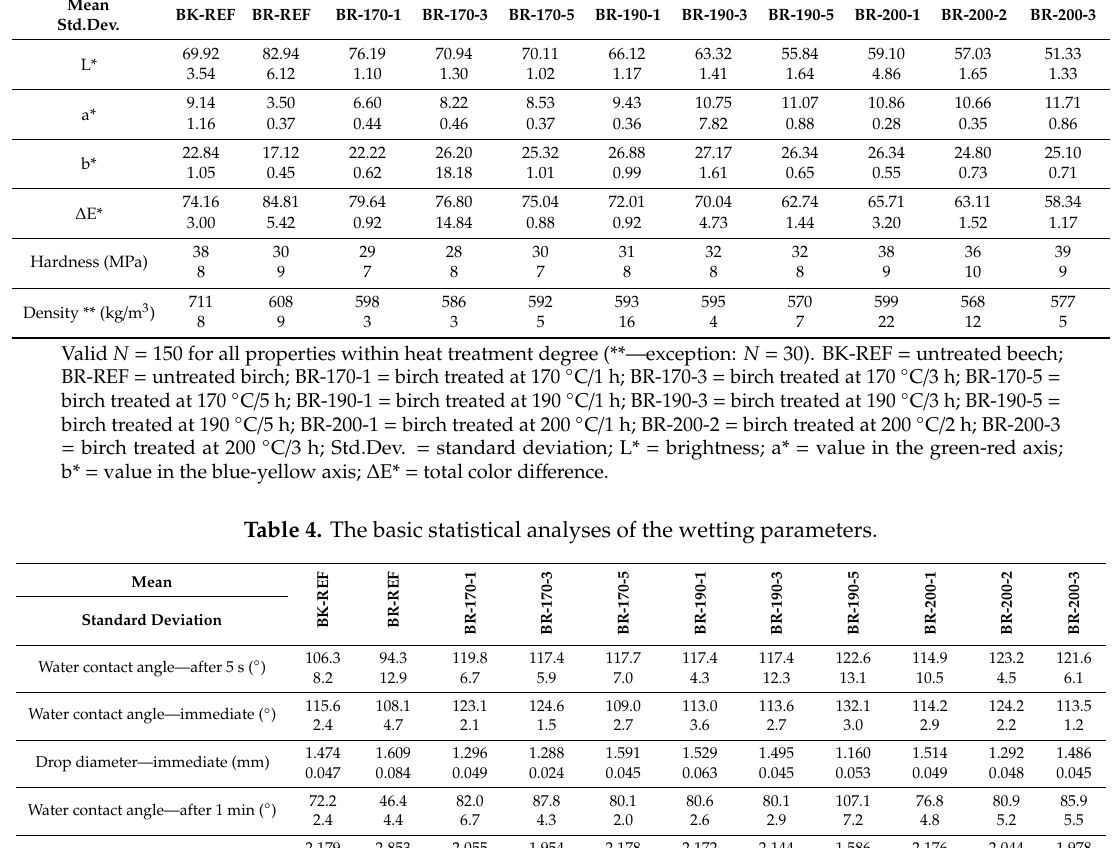
Table 3. The basic statistical analyses of the colorimetric parameters, hardness and density. Mean Std.Dev.